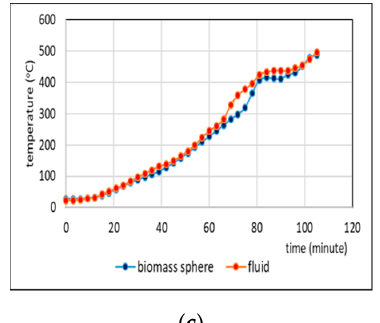
Figure 8. Comparison of temperatures of biomass spheres and co-pyrolysis fluid. Co-pyrolysis used a feed containing 75% weight of PP: Thermocouple #3 ( a ), Thermocouple #4 ( b ), Thermocouple #5 ( c ).